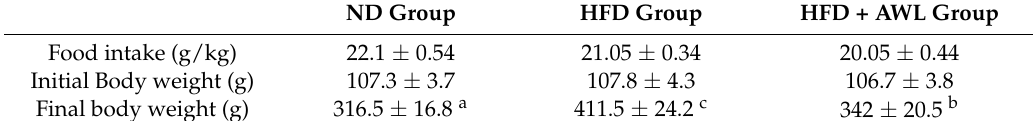
Table 1. Effect of AWL on body weight and food intake in rats fed HFDs for five weeks. The effect of AWL on body weight and food intake in rats fed HFD for five weeks. Values are presented as the mean ± S.D. ( n = 10). a,b,c Means not sharing common letters are significantly different among the groups at p < 0.05.